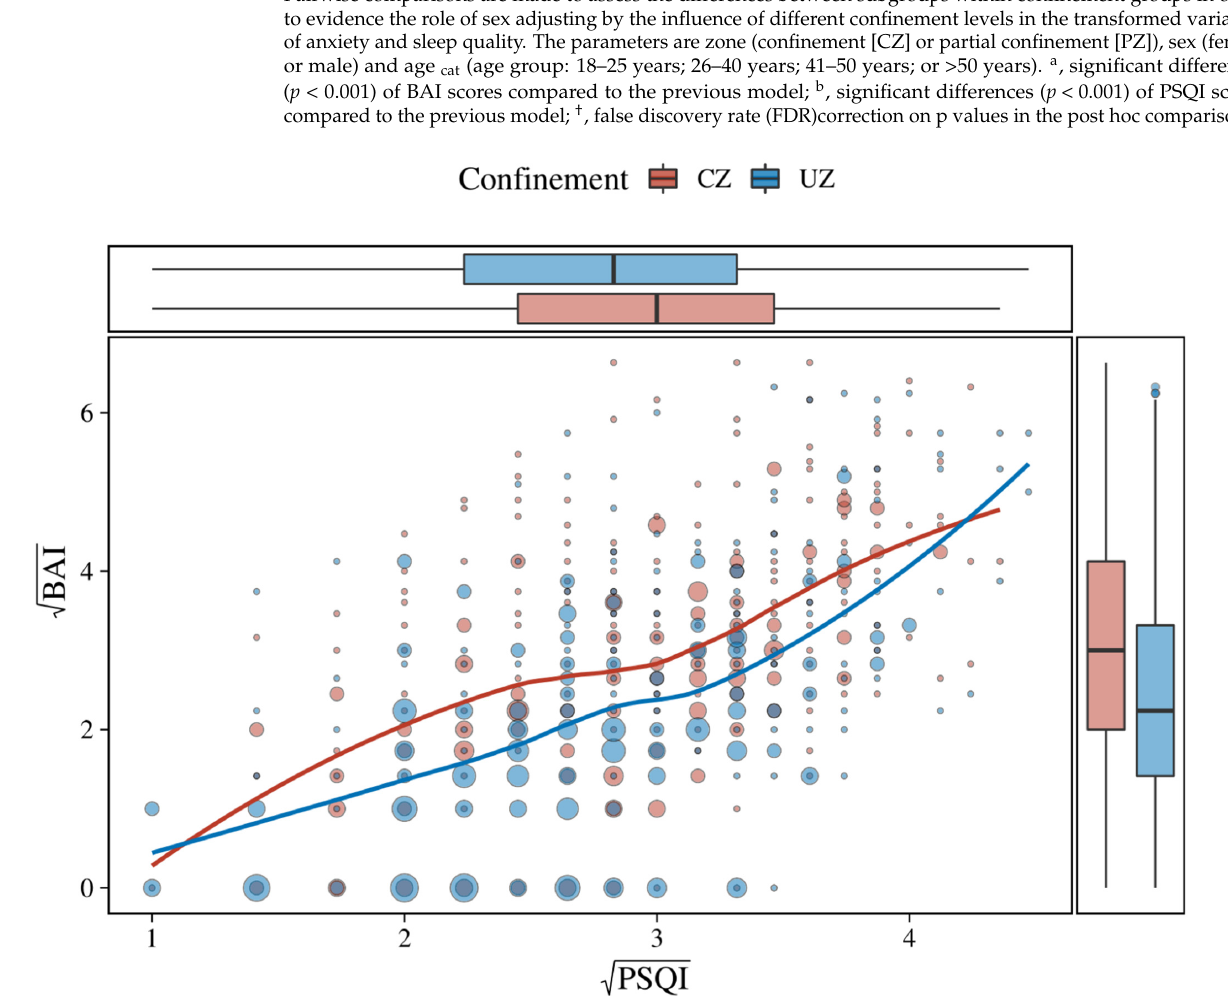
(cid:3493)𝑃𝑆𝑄𝐼 (Model 1 B vs. Model 0 B ) ( F (1, 615) = 5.84, p = 0.016). The full (final) models includ- ing both sex and age group as covariates (Model 2 P and Model 2 B ) outperformed Model 0 B and Model 1 B ( F (4, 615) = 21.51, p < 0.001 and F (3, 614) = 26.98, p < 0.001, respectively), as well as Model 0 P and Model 1 P ( F (4, 615) = 4.72, p < 0.001 and F (3, 614) = 4.32, p = 0.005, respectively). The final effects for Model 2 P and Model 2 B are shown in Figure 2.